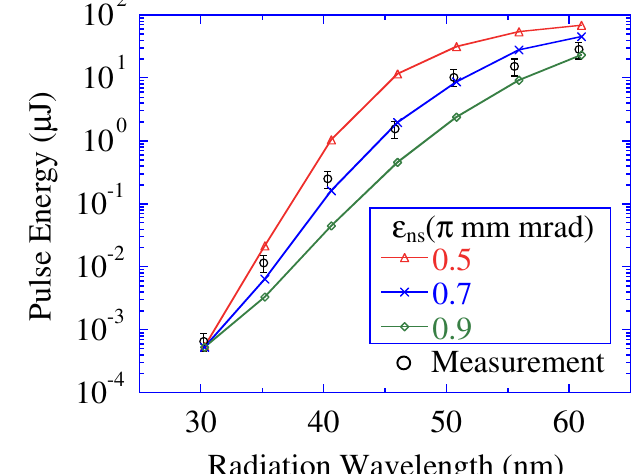
FIG. 12. (Color) Measured temporal distribution of the electron